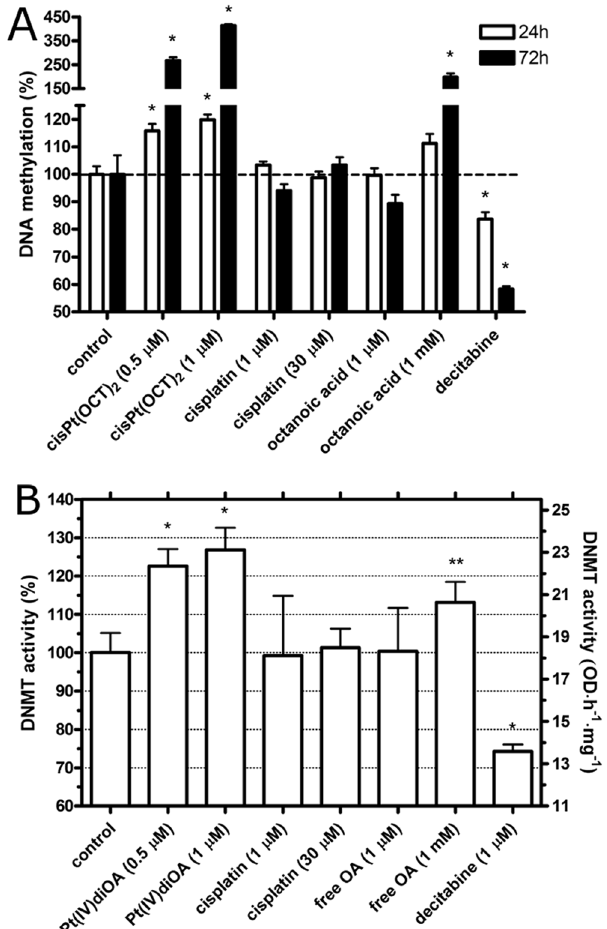
Figure 4. Analysis of DNA methylation. ( A ) DNA was isolated from HCT-116 cells after the exposure to the agents at the concentrations indicated in the graph for 24 or 72 h. The levels of DNA methylation in the control was taken as 100%. The bars represent mean values from three independent experiments each performed in octuplicate. The error bars are the SDs. ( B ) DNMT activity in colon carcinoma cells HCT-116 treated for 24 h with the compounds tested in the present work. The DNMT activity in the control, untreated cells was taken as 100%. Error bars are the SDs and the stars at the top of bars denote a significant difference from the control with ( * p < 0.05; ** p < 0.1), calculated using nonparametric student’s t-test. The bars represent mean values from three independent experiments, each performed in